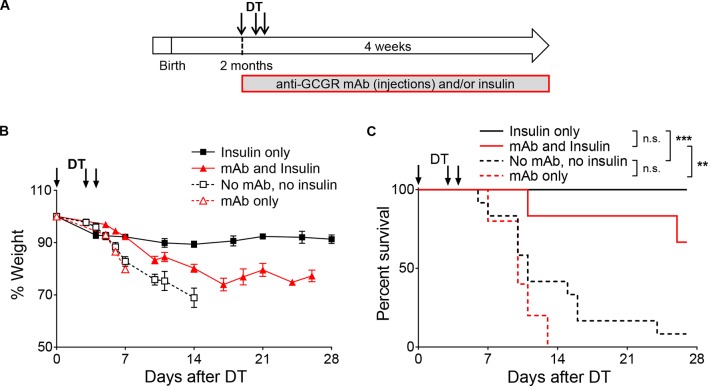
Insulin administration is required to stabilize body weight and allow survival of anti-GCGR-treated mice after DT.(A-C) Exogenous insulin, but not anti-GCGR mAb treatment, stabilizes body weight and improves survival after extreme β-cell loss. (A) Experimental design. (B) Evolution of body weight following DT administration in RIP-DTR males treated with anti-GCGR mAb and/or exogenous insulin (N=5–12). (C) Survival curves. Survival analyses are indicated next to the legend: n.s., not significant; **p<0.01; ***p<0.001; Log-rank test. Insulin was administered as subcutaneous implants (antibody-untreated mice), or as injections of long-acting insulin (antibody-treated mice) because insulin implants lead to hypoglycemia and death in mice with deficient glucagon signaling.